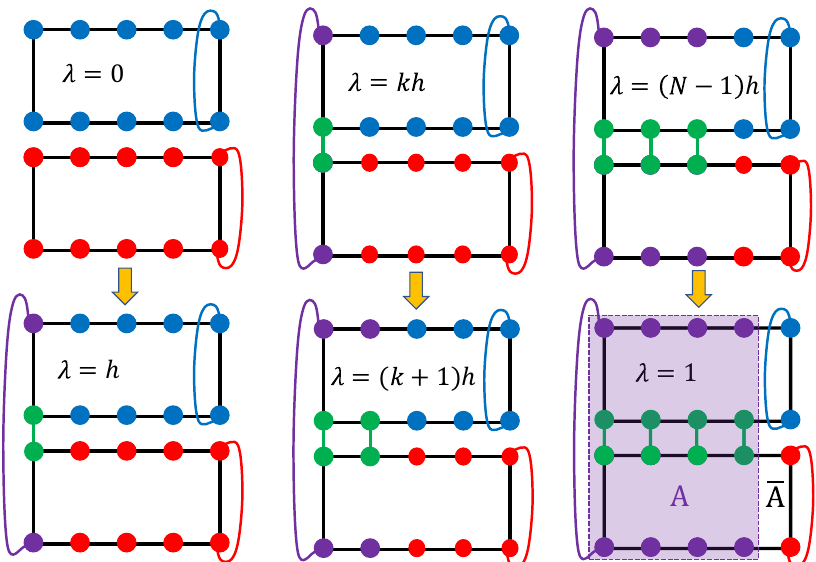
Fig. 6 A schematic plot of the nonequilibrium increment algorithm. It splits a consecutive λ − parameterized nonequilibrium process into N independent smaller pieces. For each piece we start from a thermalized state of the partition function Z ð 2 Þ nonequilibrium measurement from λ = kh to λ = ( k + 1) h . For the k = 0 piece (the left column), the starting con fi guration is two independent replicas with ordinary periodical conditions and as the system evolves to λ = h the con fi guration becomes two modi fi ed replicas with some sites in region A are glued together. The k = h (the middle column) and k = ( N − 1) h (the right column) pieces are carried in parallel. The fi nal entanglement entropy is obtained from the summation of these independent pieces, as shown in Eq. (15).